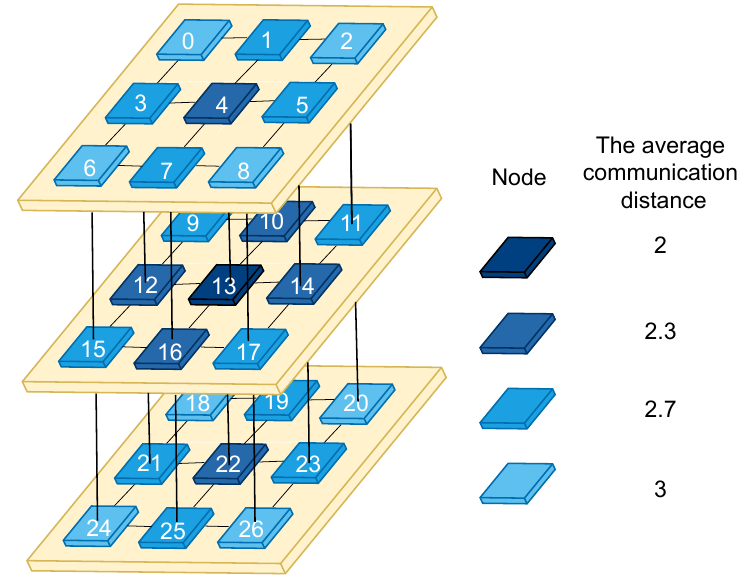
Figure 1. Average distance between nodes in a 3 × 3 × 3 mesh